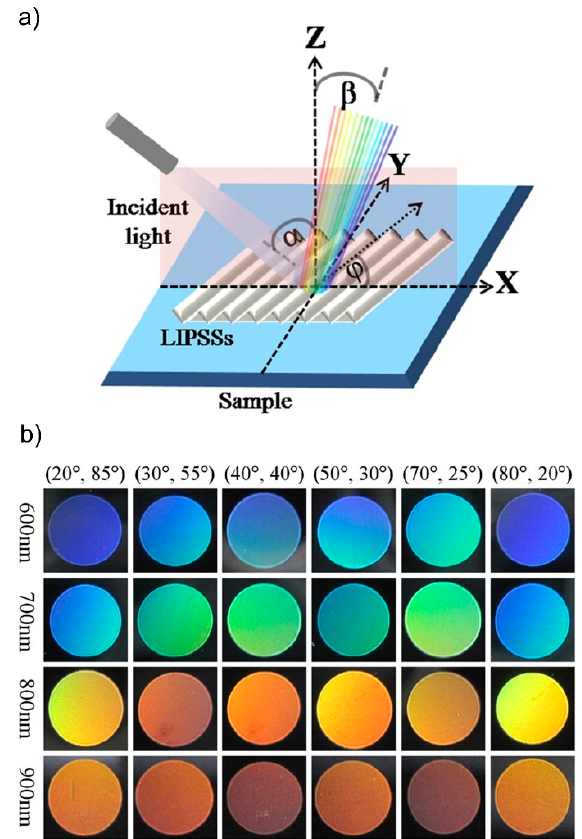
Figure 16. Structural colors formed with different spatial periods: ( a ) principle of the color measuring setup and ( b ) photographs taken at fixed observation angle β = 20° (left axis: spatial periods, upper axis: value pair ( α , φ ) consisting of α —orientation of the incident light to the Z -direction and φ —ripple direction to X -direction). Adapted from Li et al . [114], with permission of Springer.